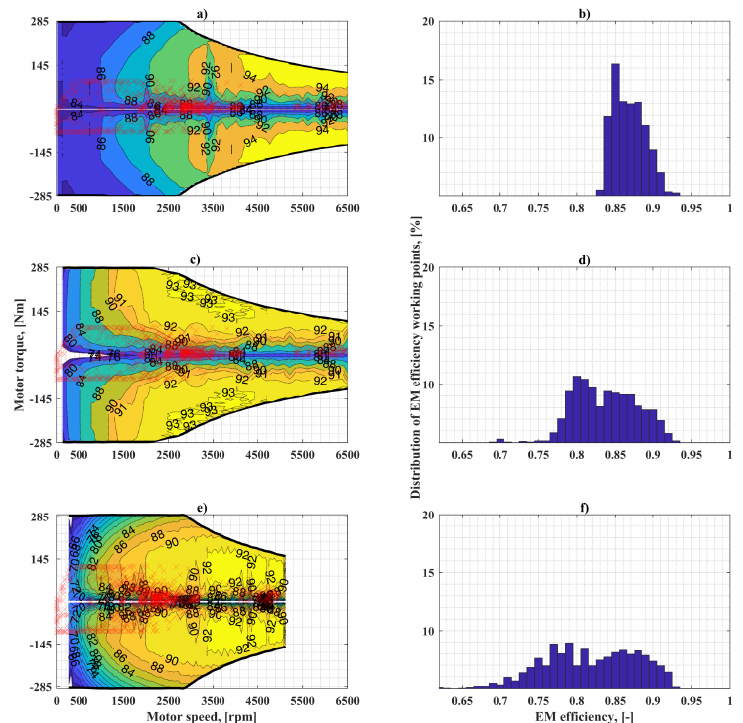
Figure 8. Working points during the UDDS cycle with different EMs installed on Kia Soul BEV. Re-scaled characteristics to Kia Soul and distribution of re-scaled EMs working points. Kia Soul EM ( a , b ); BMW i3 EM ( c , d ) ; YASA EM ( e , f